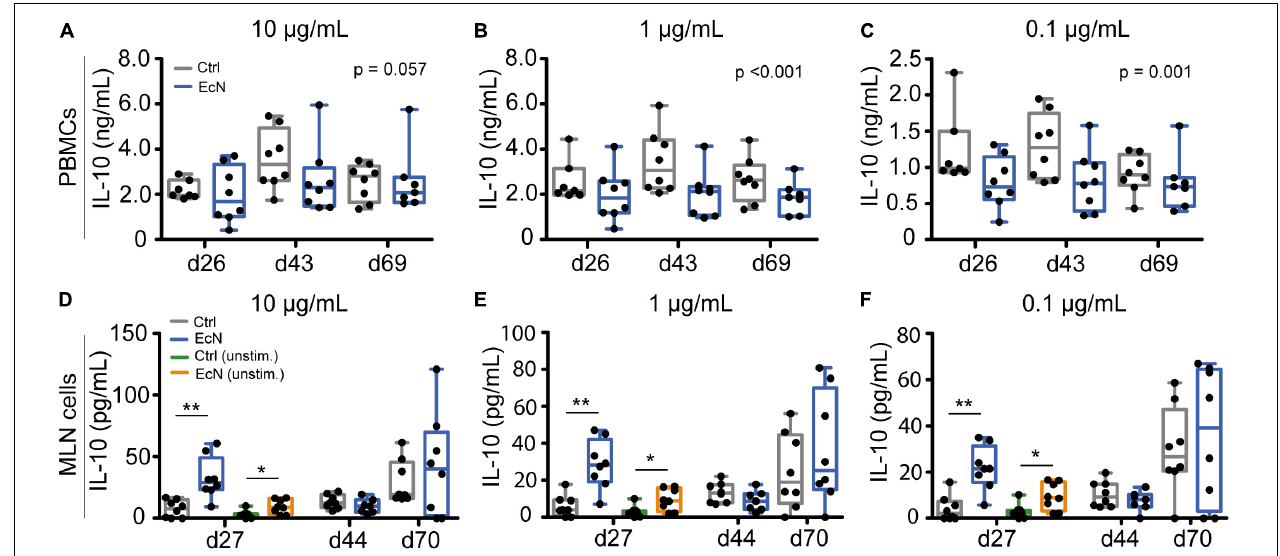
FIGURE 7 | IL-10 production upon ex vivo stimulation of PBMCs and MLN cells. PBMCs (A–C) and MLN cells (D–F) were stimulated for 24 h with 10, 1, and 0.1 µ g/mL of LPS, or left unstimulated (cell culture medium only). P -values indicate significant differences between treatment groups over time (A–C) , and asterisks are used to demonstrate significant differences between treatment groups after taking into account single time points (* p < 0.05 and ** p < 0.01, D–F ). Every point represents an individual animal from a separate pen ( n = 7 or 8 per treatment group), and error bars represent standard deviations. Normal distribution and equal variances of data were checked and log-transformed when necessary. No differences in IL-10 production by unstimulated MLN cells were observed post-weaning and are therefore not presented.